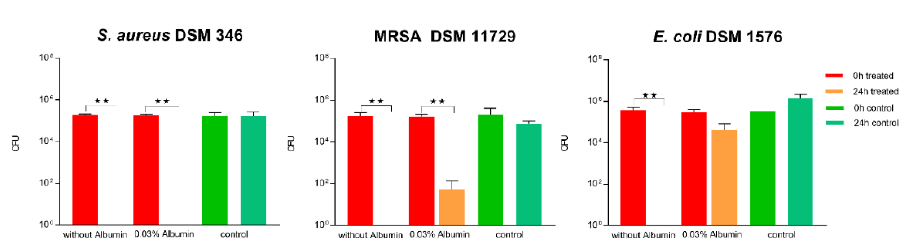
Figure 6. Quantification of viable bacteria using ISO 22196 with low soil load with 0.03% bovine albumin. The results of two independent experiments are shown. A volume of 100 µL of bacterial inoculum was incubated at 99% humidity and 37 °C for 24 h on the 2.5% Cu(NO 3 ) 2 -containing sol–gel surface, as well as a sol–gel surface without additive (control). The initial number of bacteria was quantified immediately after inoculation (0 h treated, red; and 0 h control, green) and after 24 h of incubation (24 h treated, orange; and 24 h control, turquoise). Mean numbers of bacteria per surface (CFU) are displayed on a logarithmic scale with error bars indicating the standard deviation of the respective means. Statistically significant differences between the number of viable bacteria after 24 h of incubation are marked. (Mean with 95% CI, Mann–Whitney-U test; ** corresponds to p ≤ 0.004).